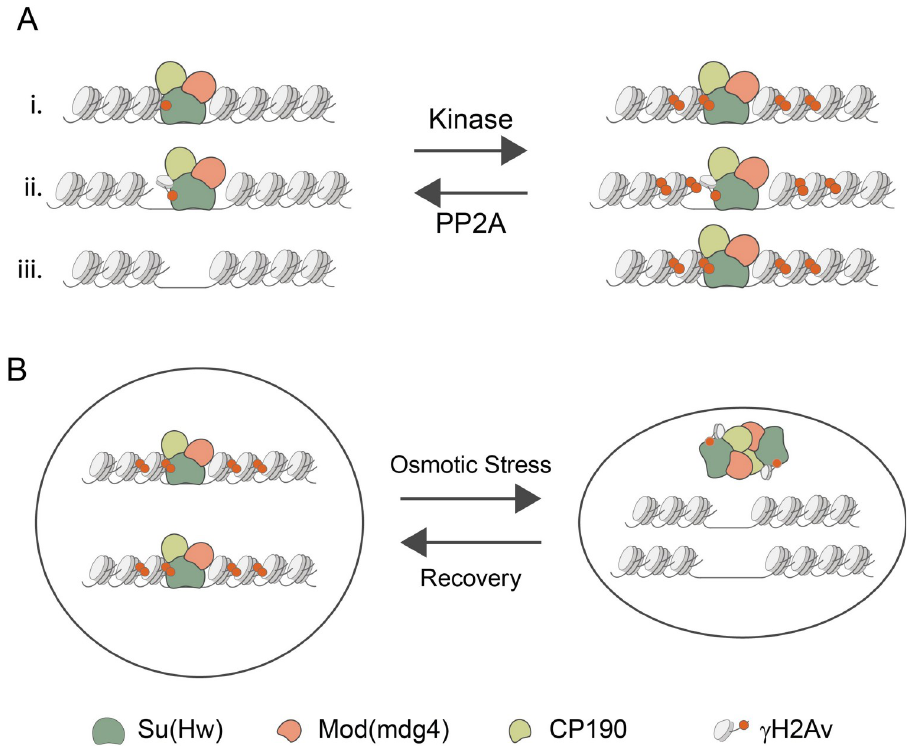
Fig 8. A proposed model illustrating the role of interactions between gypsy insulator components and γ H2Av. A. We speculate that binding of the Su(Hw) insulator complex promotes phosphorylation of neighboring H2Av. This stabilizes binding of the insulator complex and promotes spread of phosphorylated H2Av through neighboring nucleosomes. (i.) Case in which Su(Hw) complexes interact with nucleosomal γ H2Av. (ii.) Case in which Su(Hw) complexes interact with non-nucleosomal γ H2Av. (iii.) Case in which Su(Hw) is absent and γ H2Av is significantly reduced. B. During osmotic stress, insulator complexes leave chromatin and form insulator bodies. These bodies contain γ H2Av that must be dephosphorylated during recovery so that insulator proteins can return to their genomic binding sites. The mechanism by which γ H2Av interacts with Su(Hw) insulator components is still unknown. In addition to direct interactions γ H2Av may also interact with insulator proteins through weak multivalent interactions [89].